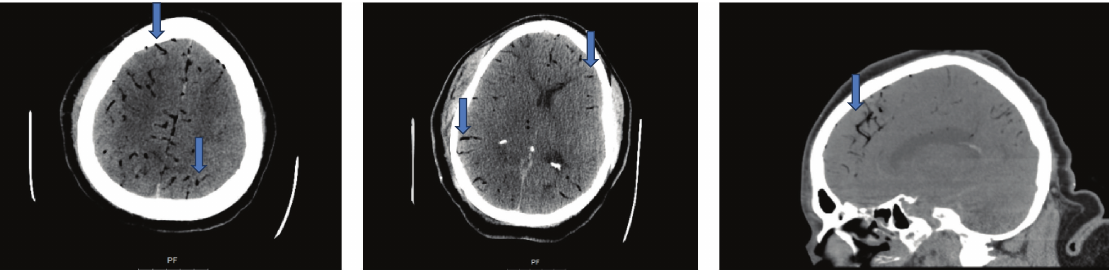
Figure 2: Case 2 CT scan of head: axial and sagittal cuts showing foci of gas in bilateral cerebral arteries (blue